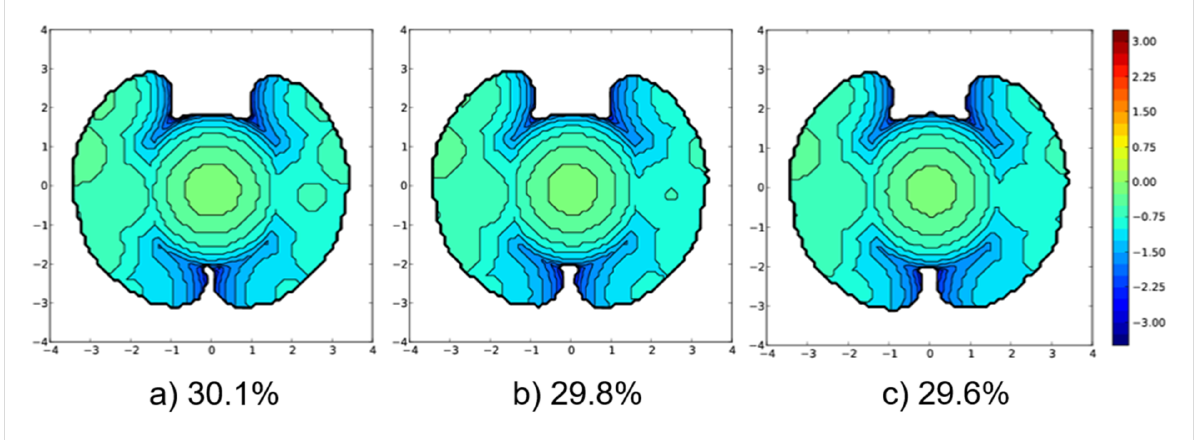
Figure 1: Topographic steric maps (plane xy) of the NHC ligands of species I for the studied SIMes–Ru complexes 1 , 3 and 5 , with a radius 3.5 Å. %V Bur is the percent of buried volume. The Ru atom is at the origin and the Ru–C NHC bond is aligned with the z -axis, and the Ru–C ylidene with the x -axis. The isocontour curves of the steric maps are given in